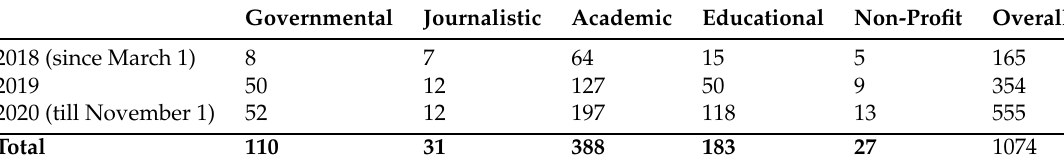
Table 2. Formal data access requests to the OpenSky Network, including splits for research-relevant sub-fields. The numbers for overall requests additionally contain non-institutional, commercial, or other non-research requests not discussed in this